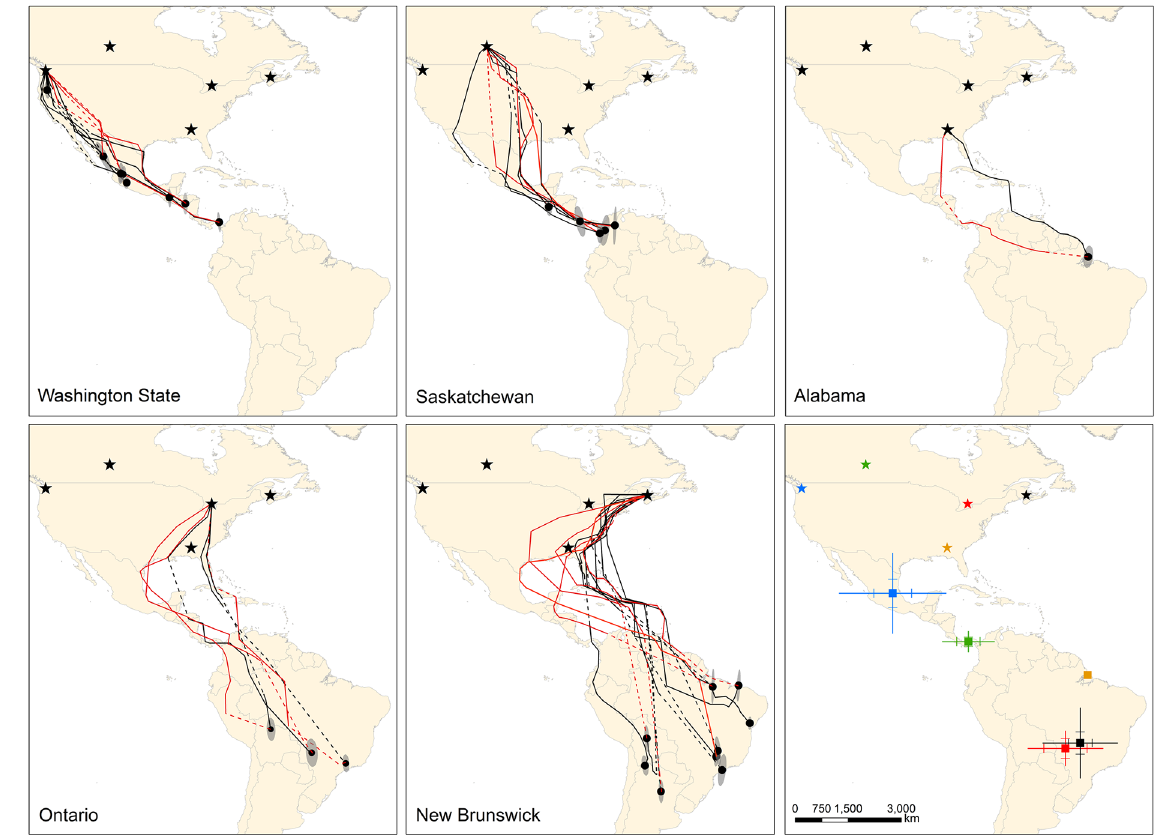
Fig 1. Estimated fall and spring migration routes and wintering sites for barn swallows from five populations where archival light-level geolocators were deployed. Predicted fall (black lines) and spring (red lines) migration routes and mean wintering locations (black dots) from Kalman filter state-space models. Dashed lines are estimated routes during periods when locations could not be accurately assessed (e.g., equinox, unrealistic points). Ellipses represent directional standard deviations of points used to calculate mean wintering locations. Breeding locations are denoted (stars). Data are for 13 females, 13 males and 1 unknown sex. The last panel indicates mean ± SD and SE (hash marks) for estimated mean wintering locations for five populations (blue = Washington State, green = Saskatchewan, red = Ontario, black = New Brunswick, orange = Alabama).